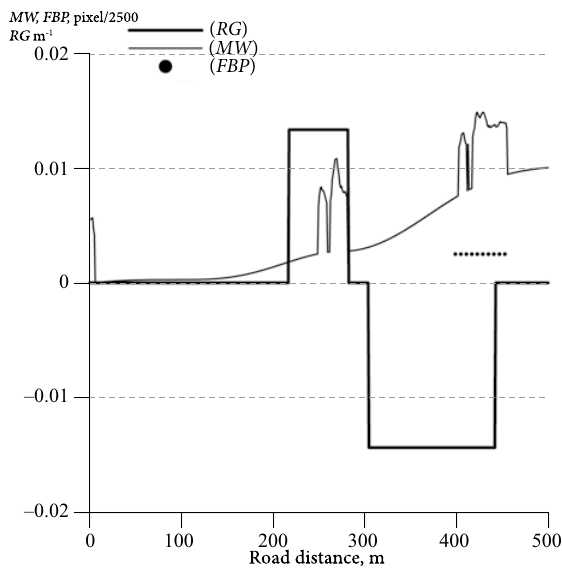
Fig. 5. Relationship between MW , deduced from the sum of E and VLI ; in the section from 400 to 460 m there is an activity on the foot/break pedal represents an overload